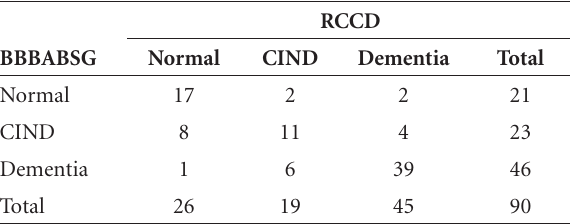
Table 1. Diagnoses of the individuals by the Reference Center for Cognitive Disorders (RCCD) and by the Brain Bank of the Brazilian Aging Brain Study Group (BBBABSG).